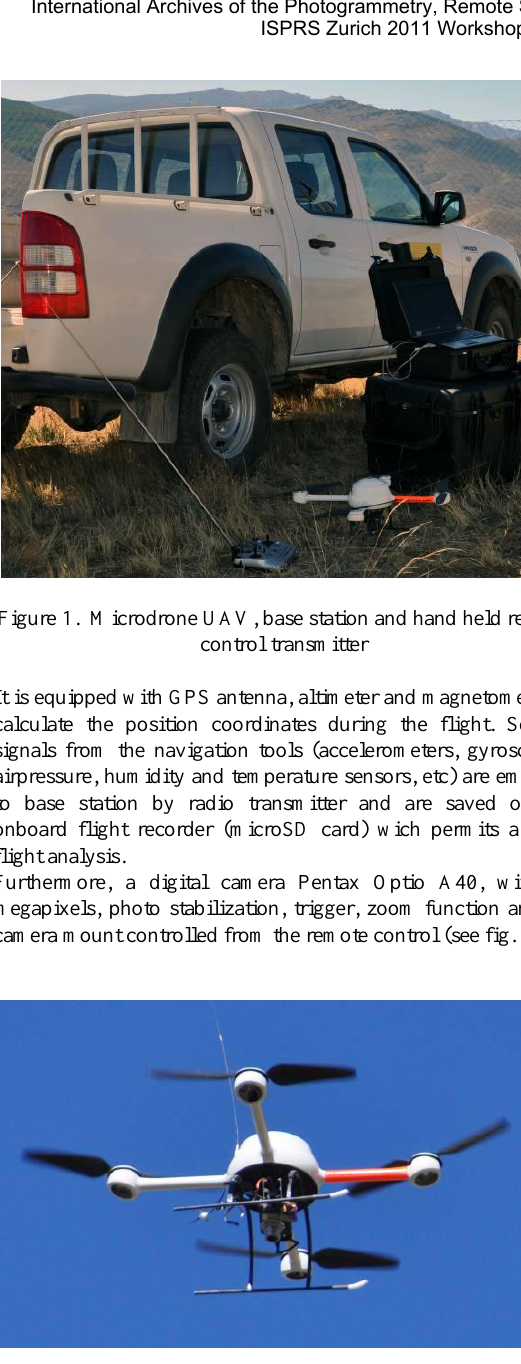
Figure 2. On-board digital camera Pentax Optio A40